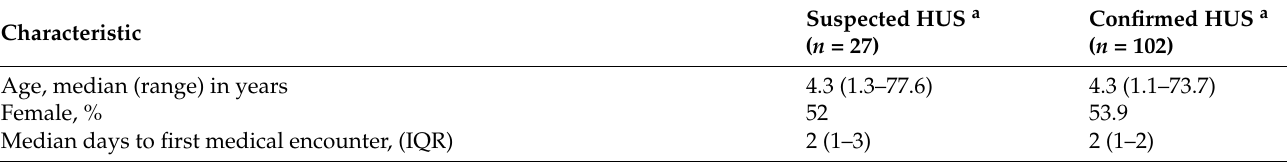
Figure 1. Diagram of study enrollment. An infection was excluded if the patient (or guardian) did not speak English or Spanish, did not report diarrhea, or could not be contacted by 10 telephone attempts within 45 days after collection of the specimen that yielded O157. The 747 persons who were not enrolled were similar to the 1329 enrolled patients with respect to age and sex: among those enrolled, median age was 15 years (IQR 5–40) and 52% were female; among those not enrolled, median age was 16 years (IQR 7–36) and 53% were female. Table 1. Demographic and clinical characteristics of confirmed and suspected HUS